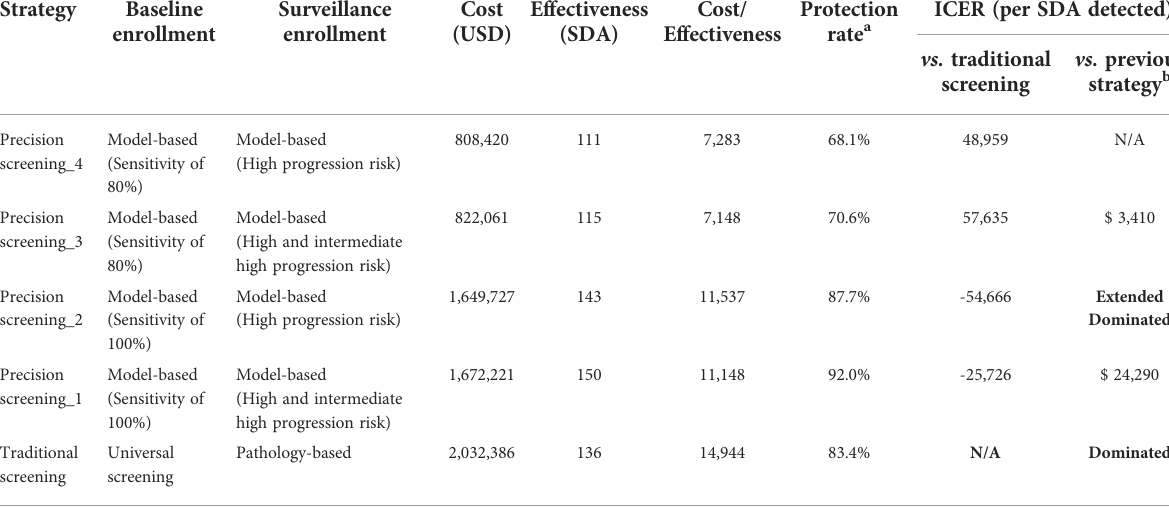
TABLE 2 Cost-effectiveness of esophageal cancer screening strategies from the ESECC trial in high-risk areas of China.